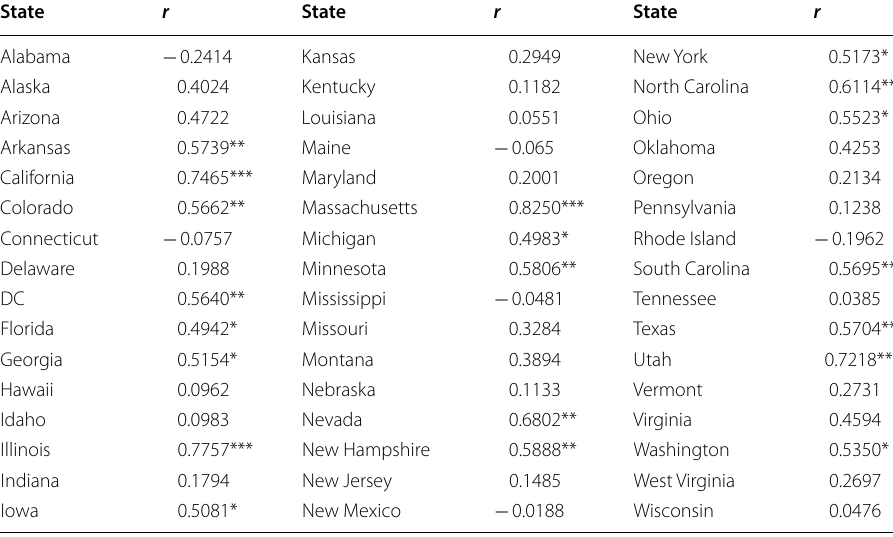
Table 5 Correlations between Google Trends data and Syphilis cases by state